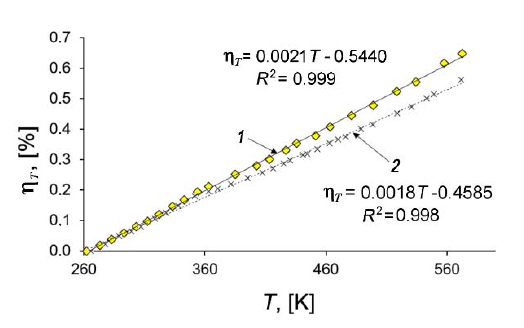
Figure 7. Relative length changes of the SiC-AC adsorbent (1) and quartz mockup (2) with temperature. Symbols are experimental data; solid straight lines are the linear approximations.